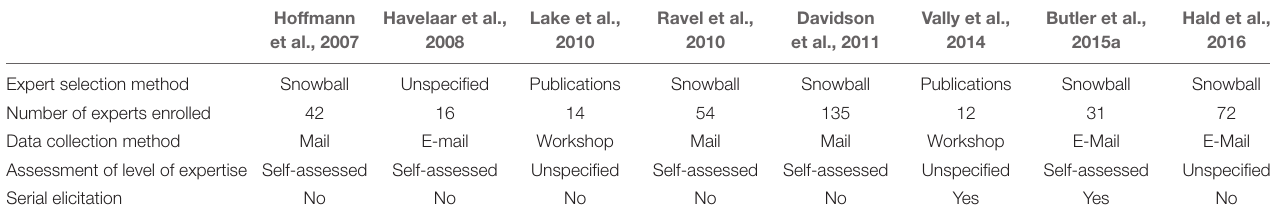
TABLE 3 | Overview of source attribution studies by elicitation of expert